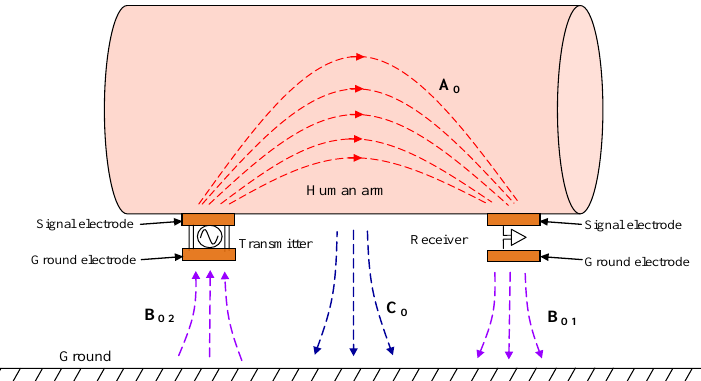
Figure 2. Schematic diagram of ( a ) on-body IBC based on capacitive coupling and ( b ) implant IBC based on capacitive coupling in the path of